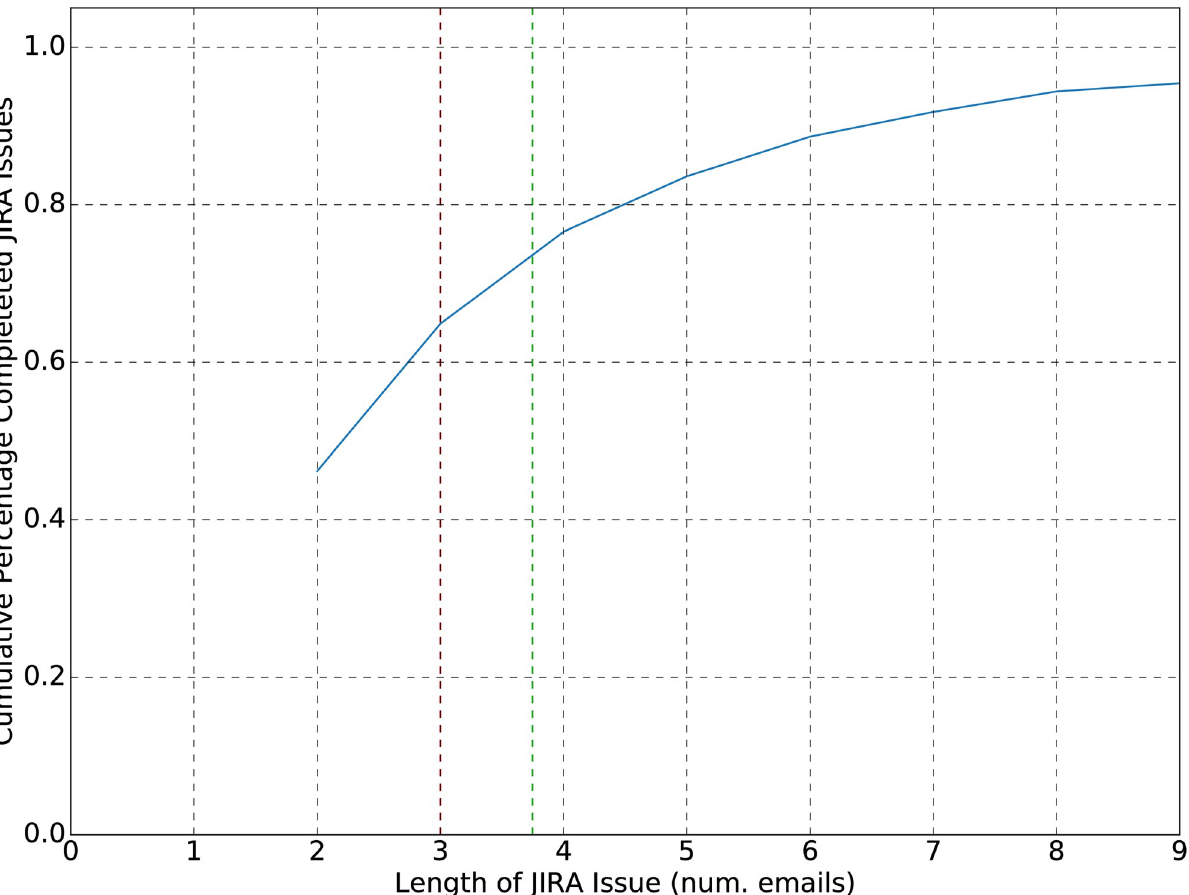
Fig 2. Length dependance of completed JIRA issues. 95% cumulative percentage of completed JIRA issues based on the length of their email chains from creation to resolution of the issue. A mean email length of 3.8, and a median of 3 was observed.